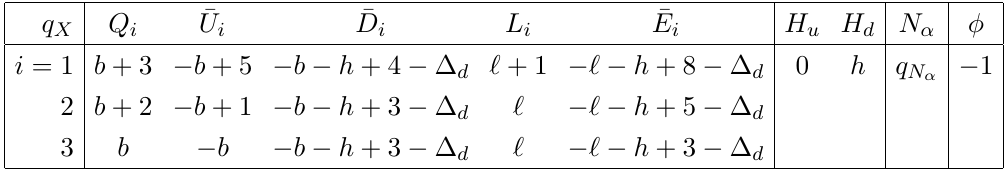
are parameters (see text). (cid:11)